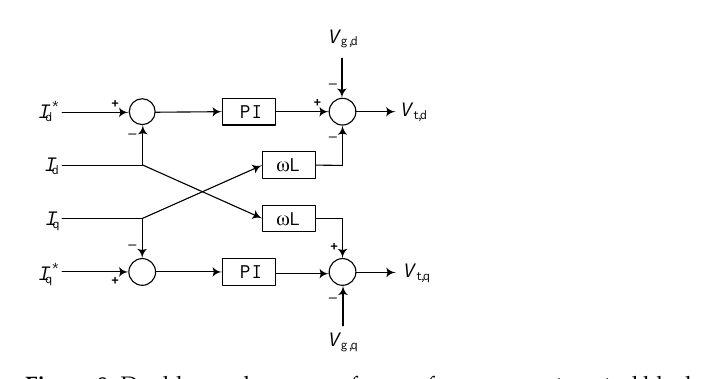
Figure 8. Double synchronous reference frame current control block.